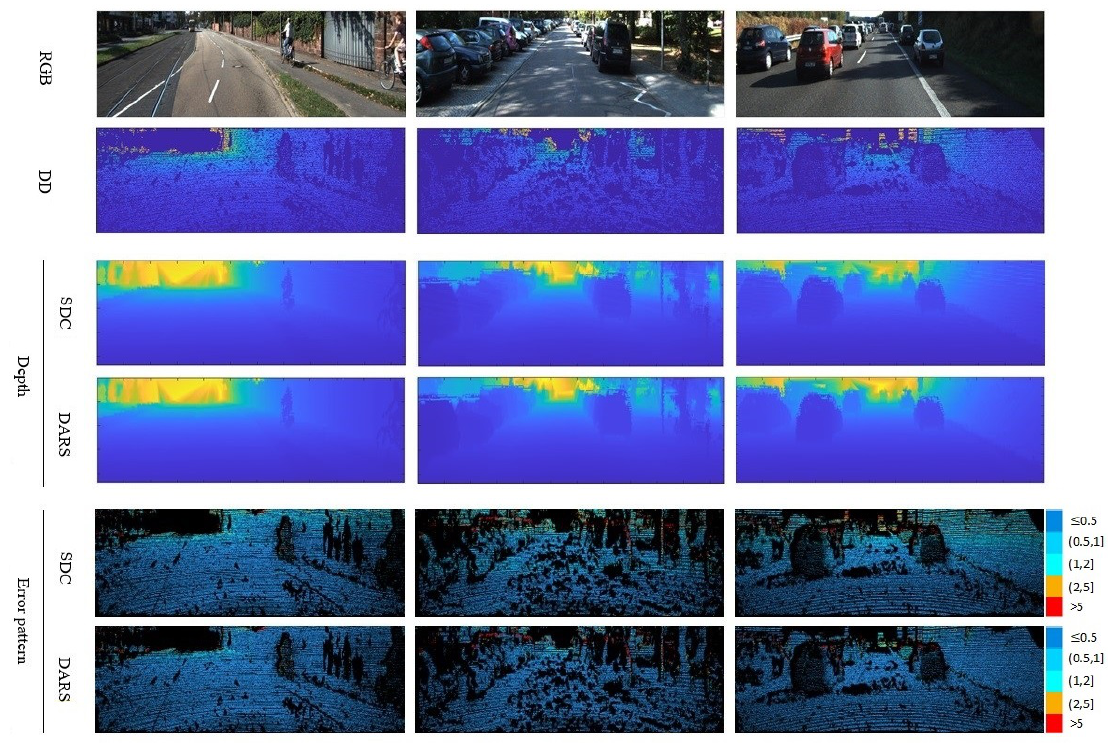
Figure 7. Visual results related to the ablation study of KITTI dataset. Numbers on the right side of error patterns are in